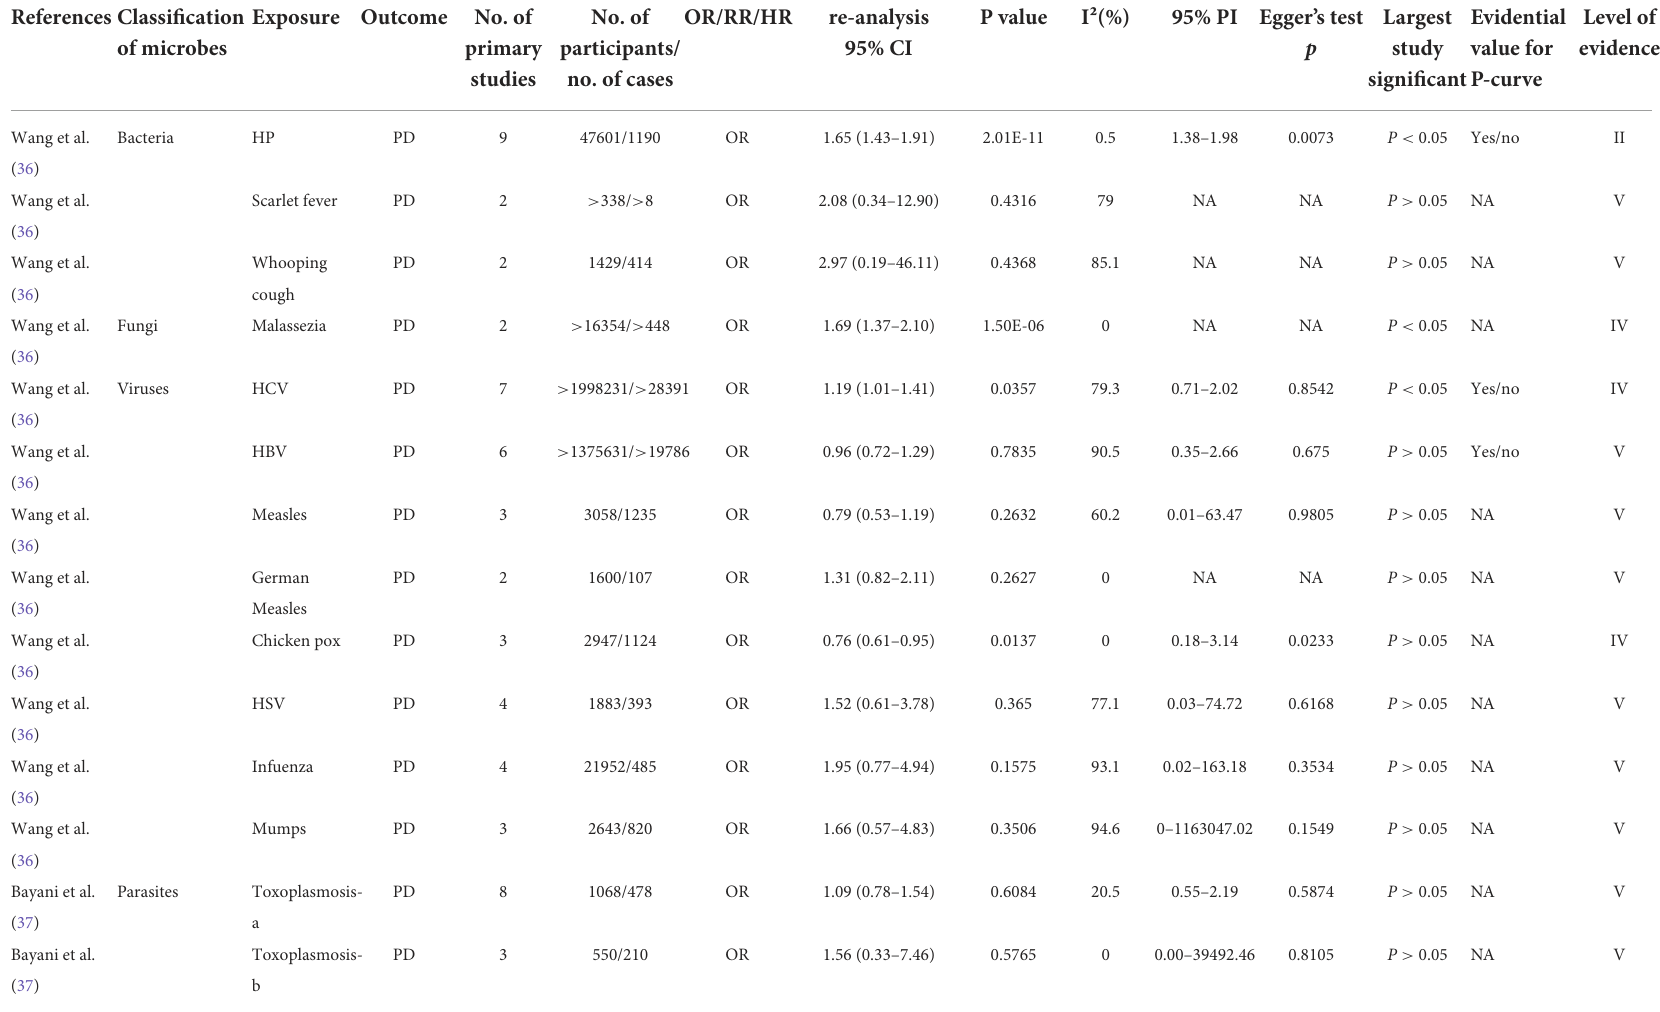
TABLE 2 Evidence of associations between microbial and neurodegenerative